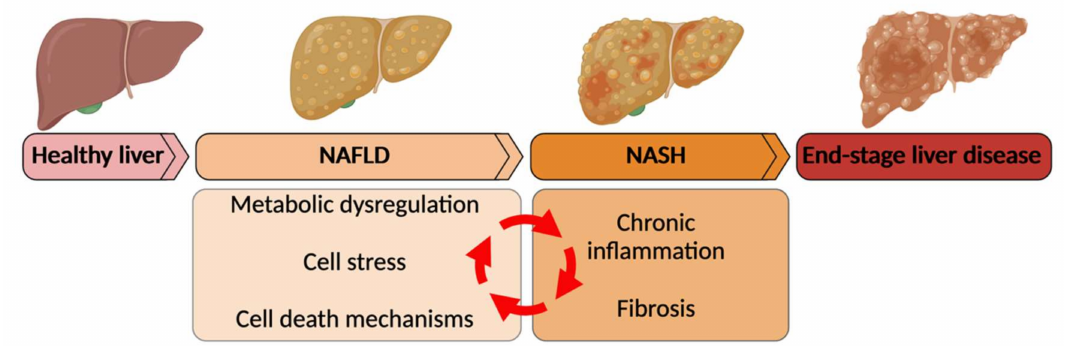
Figure 1. The spectrum of nonalcoholic fatty liver disease (NAFLD). NAFLD is a chronic liver disease that comprises a spectrum of metabolic liver diseases ranging from steatosis to nonalcoholic steatohepatitis (NASH) to end-stage liver disease including cirrhosis and hepatocellular carcinoma. Unique about the pathogenesis of NAFLD is the connected nature of the disease promoting events. Overnutrition leads to metabolic dysregulation resulting in cell stress and lipotoxicity. This triggers inflammation and recruitment of immune cells to the liver. Cell stress and inflammatory stress lead to hepatocyte death, which in NAFLD can be in different forms of cell death. (Created with Biorender.com, accessed on 23 February